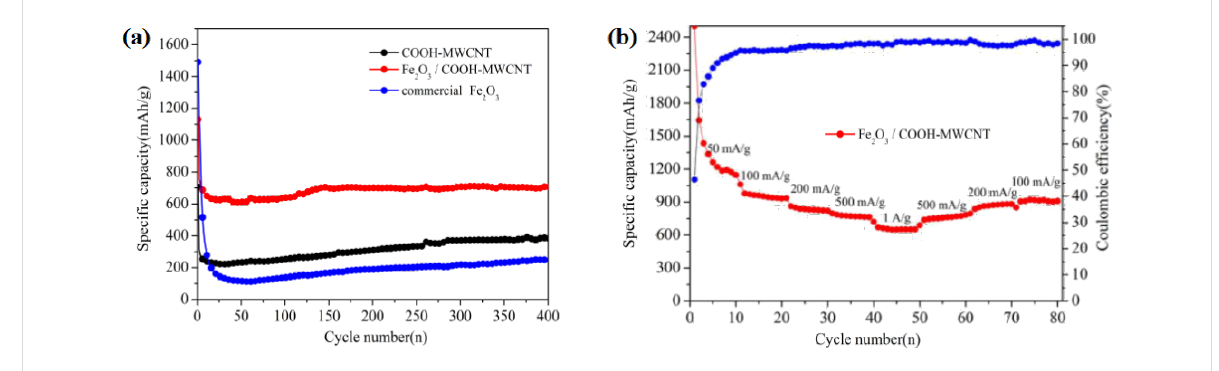
Figure 5: Electrochemical performance of the Fe 2 O 3 electrode: (a) Comparisons of the cycling performance among COOH-MWCNT, Fe 2 O 3 /COOH- MWCNT composites and commercial Fe 2 O 3 at a current density of 500 mA·g − 1 ; (b) rate capability of Fe 2 O 3 /COOH-MWCNT composites.